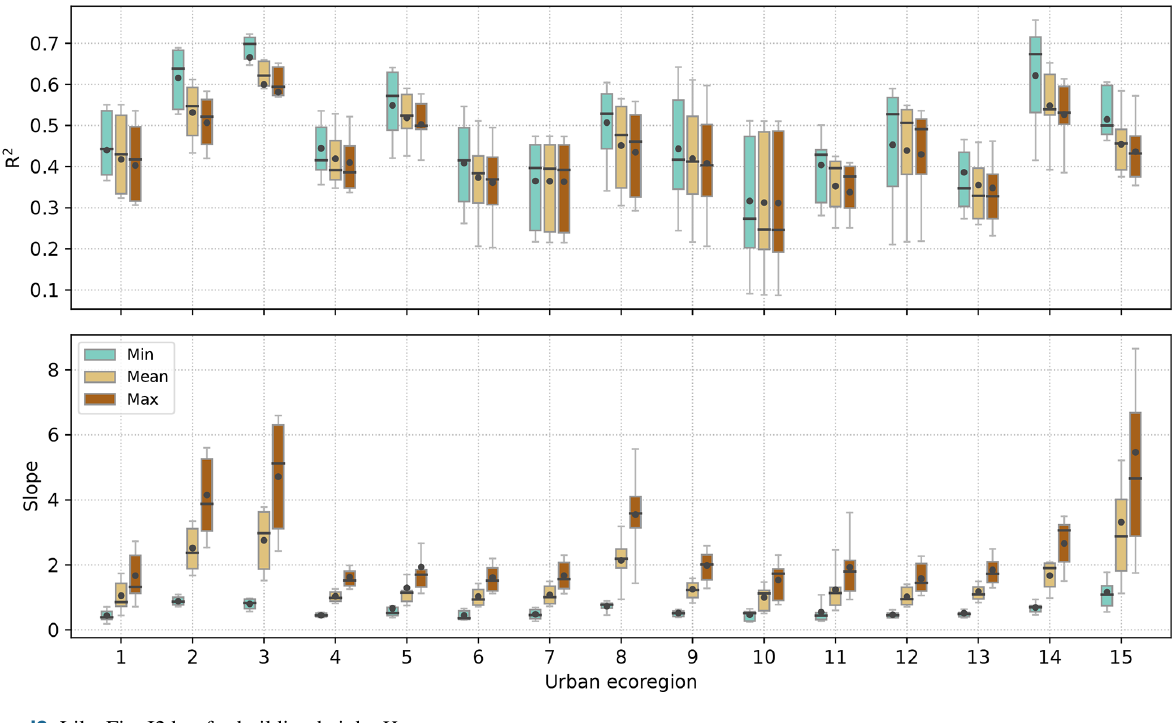
Figure I3. Like Fig. I2 but for building height H .